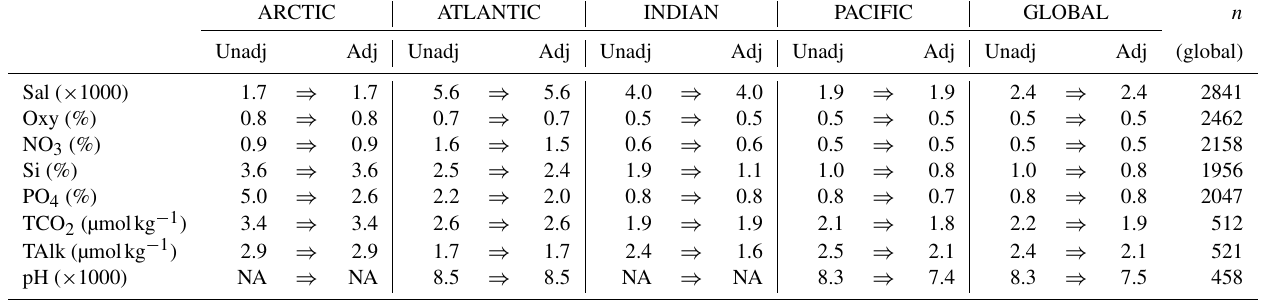
Table 7. Improvements resulting from quality control of the 106 new cruises, per basin and for the global dataset. The numbers in the table are the weighted mean of the absolute offset of unadjusted and adjusted data versus GLODAPv2.2019. n is the total number of valid crossovers in the global ocean for the variable in question.